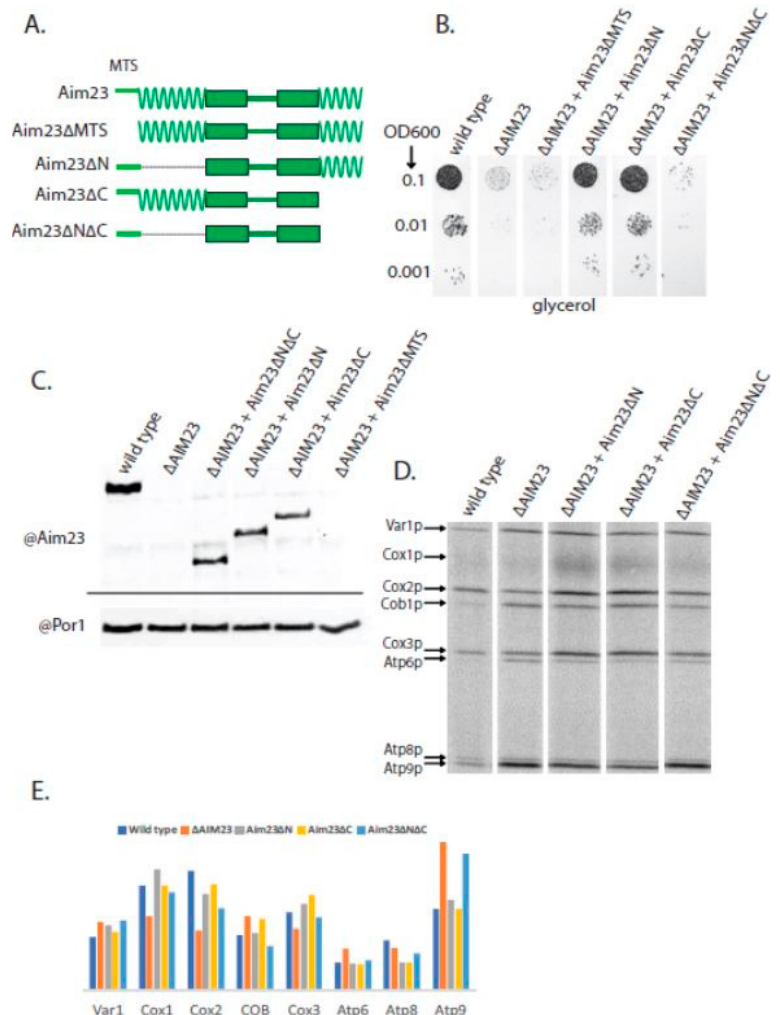
Figure 2. At least one terminal extension is required for proper Aim23p function in yeast mitochondria. ( A ) Scheme of the hybrid proteins (the names are indicated on the left). The designations of the main structural parts and their colors are the same as in Figure 1. ( B ) The plate with a glycerol-containing medium after 2 days of growth of the yeast strains indicated on the top. The ten-fold dilutions of the yeast suspensions were plated, starting from OD600 = 0.1 (indicated on the left). Wild-type: D273-10B with the AIM23 gene genomic disruption and with the Aim23p-coding plasmid. ∆ AIM23: D273-10B with the AIM23 genomic disruption containing the empty vector. All other strains: D273-10B with the AIM23 genomic disruption supplemented with the corresponding mutant Aim23p version encoded by the plasmid. The experiment has been biologically repeated three times; the characteristic result is presented. ( C ) Western-blot hybridization of mitochondrial proteins from the above-mentioned strains with anti-Aim23p antibodies (top part). As a loading control, the same samples were blotted with anti-porin 1 antibodies (bottom part). ( D ) Separation of radioactively-labeled products of mitochondrial translation of the yeast strains indicated on the top. Cytosolic translation was inhibited by cycloheximide, which was followed by the addition of 35 S-methionine incorporated exclusively in the mitochondrially-encoded proteins (for details, see Materials and Methods). The bands corresponding to all of the eight individual proteins encoded in yeast mitochondria are visible; the proteins’ names are indicated on the left. ( E ) Estimated levels of the mitochondrially-encoded proteins (indicated on the bottom) after 15 min of labeling with 35 S-methionine in the yeast strains indicated on the